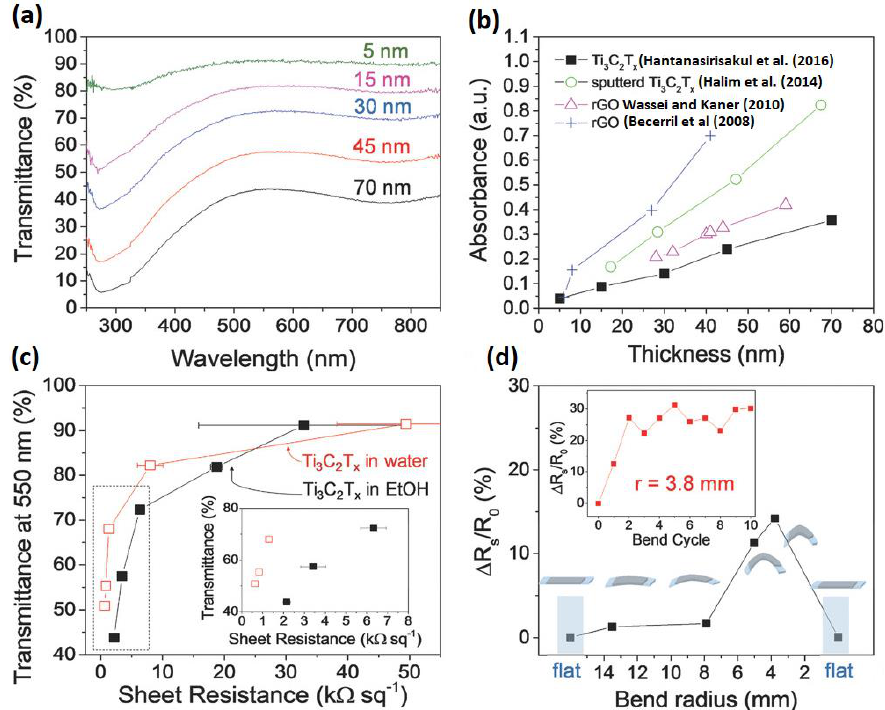
Figure 6. ( a ) UV–vis spectra of Ti 3 C 2 T x films with different thicknesses. ( b ) Effect of thickness on absorbance of Ti 3 C 2 T x [90] films compared with Ti 3 C 2 T x [91], rGO [92], rGO [93]. ( c ) Sheet resistance versus transmittance at 550 nm of Ti 3 C 2 T x sprayed from ethanol and water solutions. The inset shows the low sheet resistance region. ( d ) Bending test of a film on a flexible polyester substrate [90].